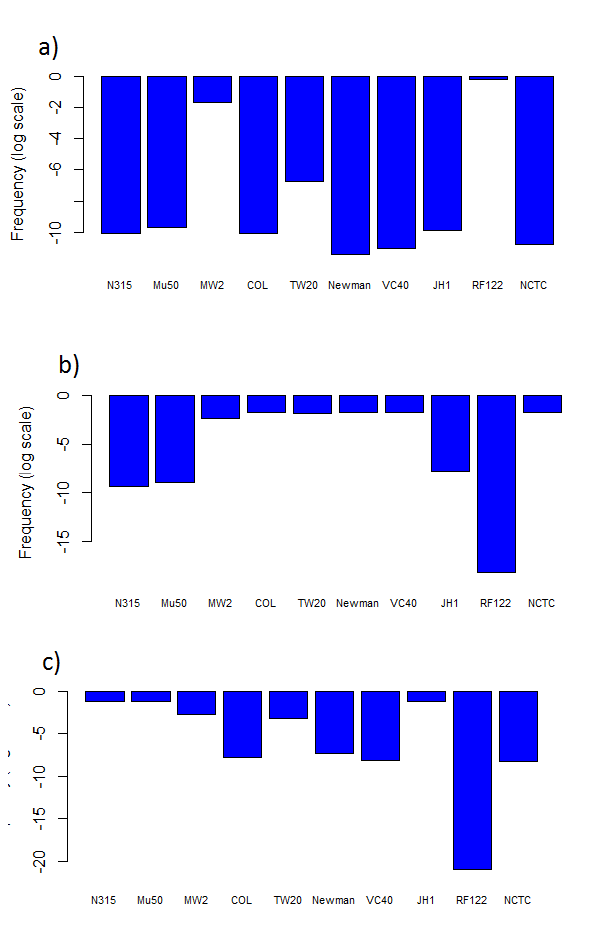
Fig. 6: Distribution of tokens in a) Component 1, b) Component 2, and c) Component 3. The first five strains are methycillin resistant, and the remainder are sensitive